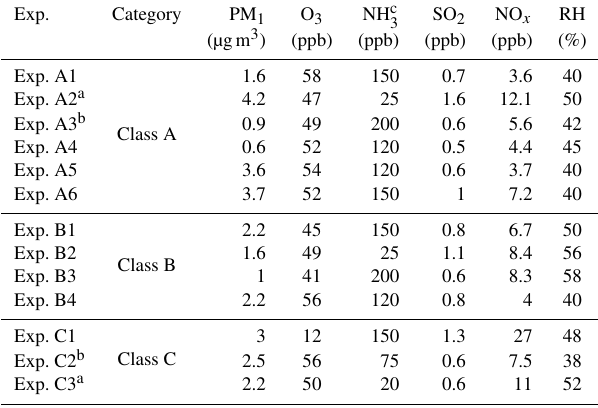
Table 1. Initial conditions in the experiments conducted.